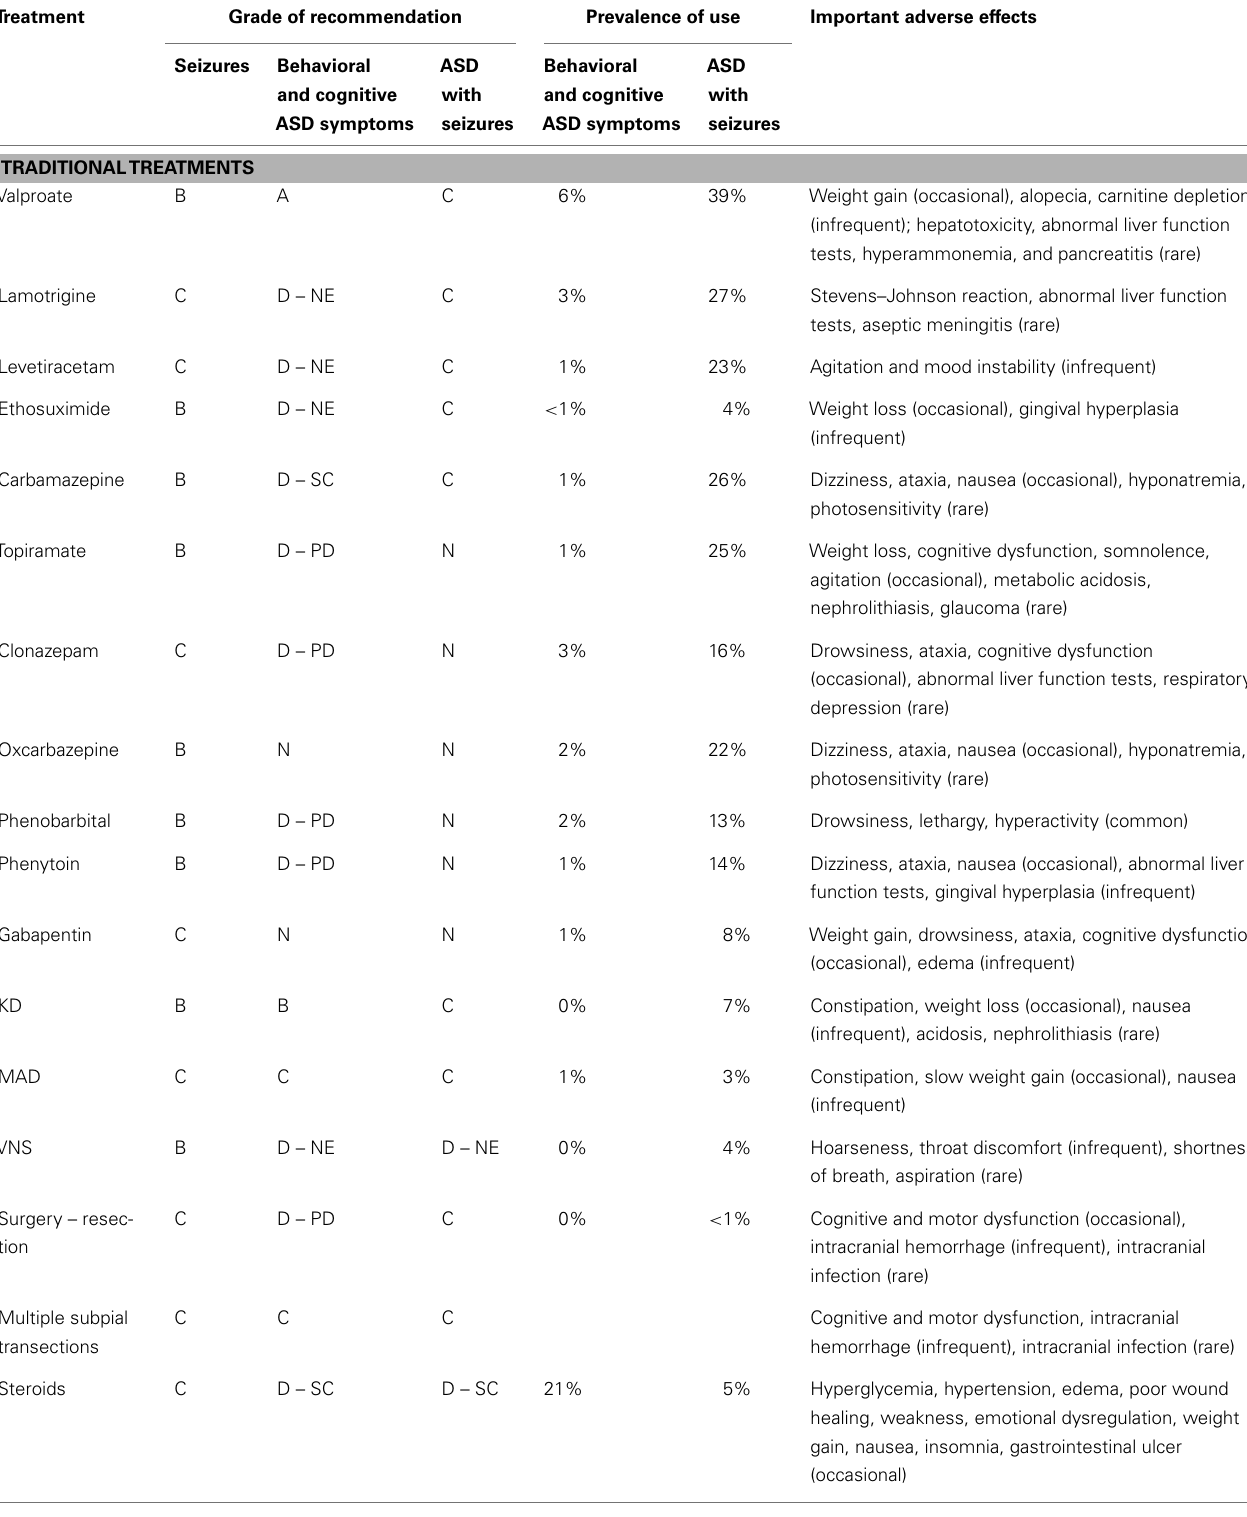
Table 3 | Seizures treatments for autism spectrum